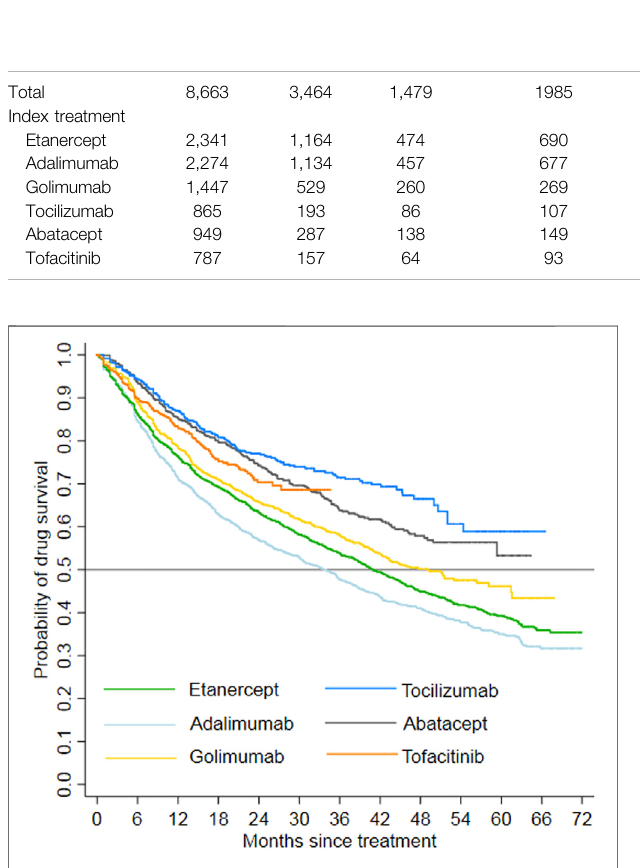
FIGURE 3 | Drug survival by index treatment (Log-rank test, p <